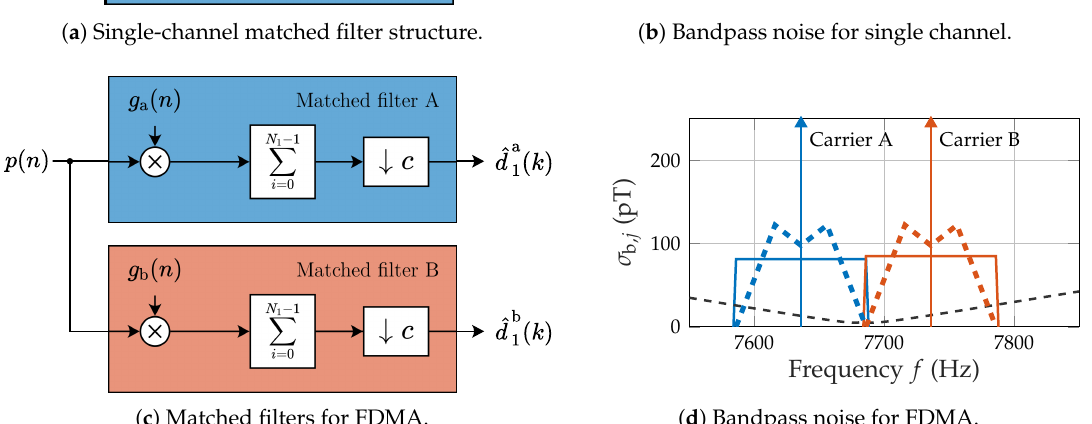
Figure 5. Matched filter structures and corresponding bandwidth considerations. Integration of the magnetic noise density (ideal conditions, cf. Figure 4c) within the specified matched filter bandwidth illustrates the effect of the matched filter length (Figure 5b). The carrier is placed at 7636 Hz (approximately f 0 − 50 Hz). Modulation due to motion will require additional bandwidth apart from the carrier. Integration within an ideal bandpass is illustrated here as a rectangle with a width (integration bandwidth) and a height (square root of the integrated noise power σ 2 ). T mf,1 yields an approximate b, j theoretical noise of 80 pT, while T mf,2 yields a significantly lower noise below 16 pT. This matched filter implementation also allows for the separation of multiple simulta- neously active carriers in a frequency division multiple access (FDMA) scheme (Figure 5c). The weighting signals g a,b ( n ) correspond to both active carriers. Subsequently, various matched filter lengths (e.g., N 1 ) might be applied in parallel. Figure 5d illustrates the placement of both carriers 100 Hz